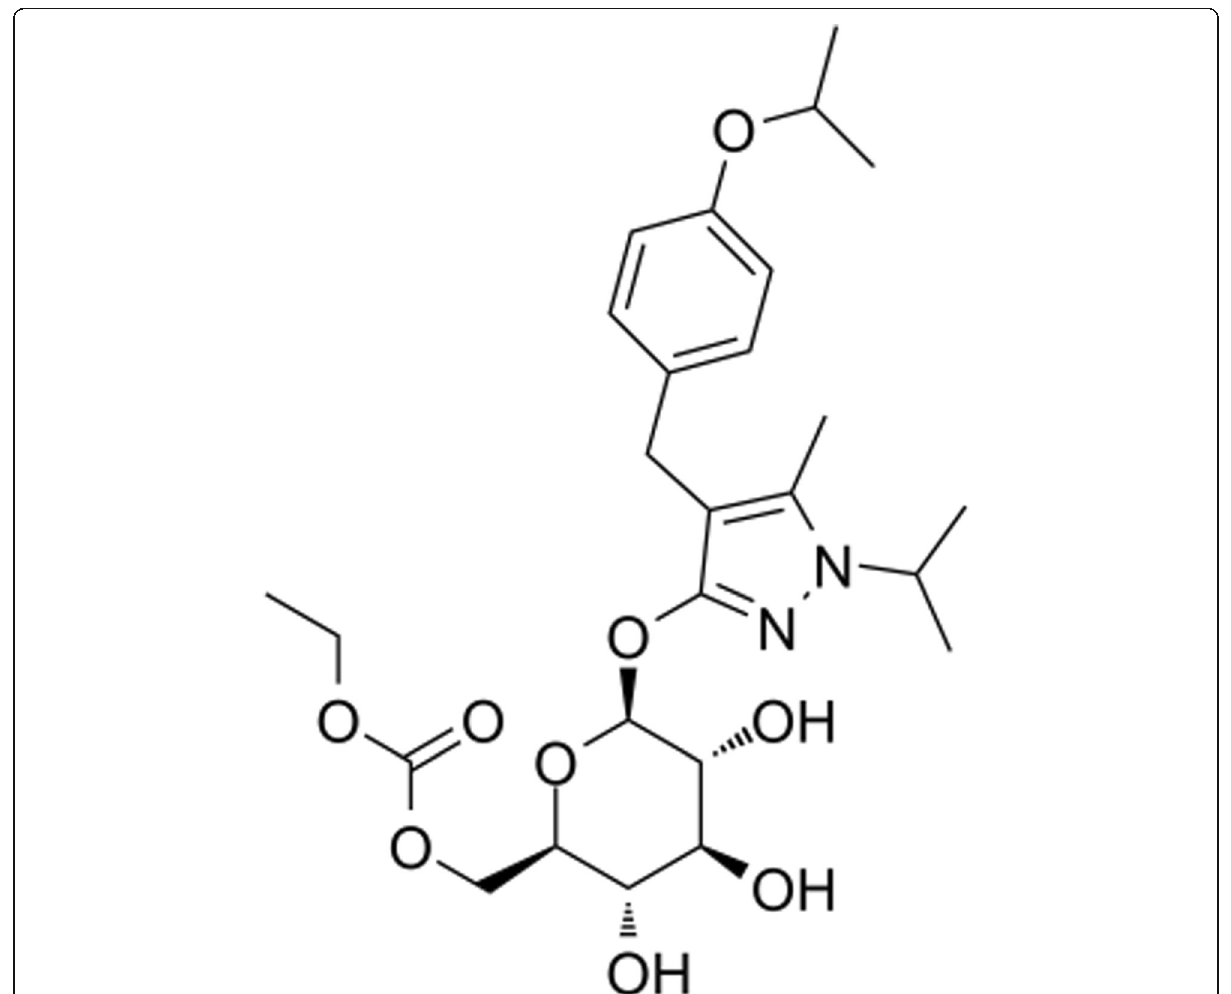
Fig. 1 Chemical structure of Remogliflozin